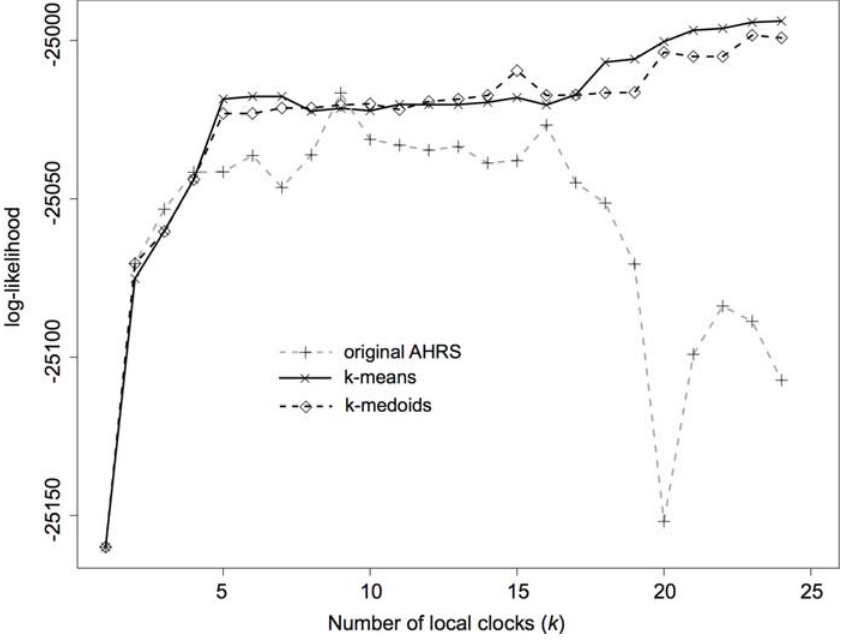
Figure 2. Maximum likelihood score as a function of the number of clocks.